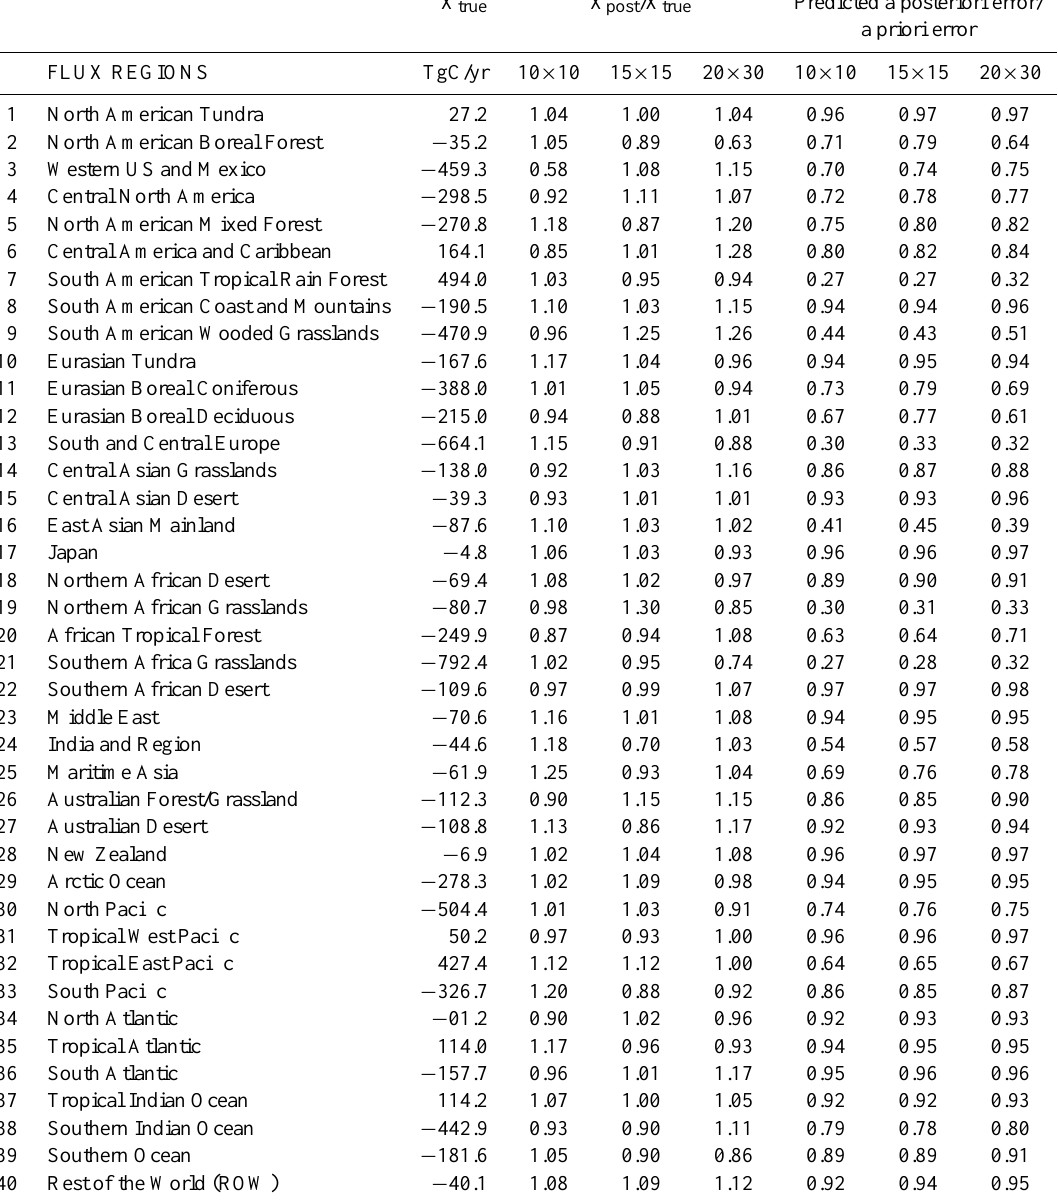
Table 7. OSSE a posteriori flux estimates compared with the “true” state along with a ratio of the a posteriori error relative to the a priori error for 40 geographic regions. The shaded regions, primarily in the tropics, show regions with the most information added from